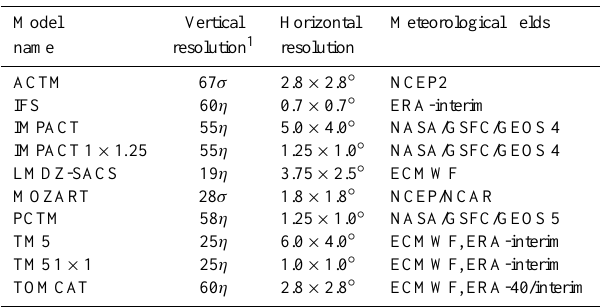
Table 1. Main characteristics (vertical resolution, horizontal reso- lution and meteorological drivers) of the TransCom models used in this